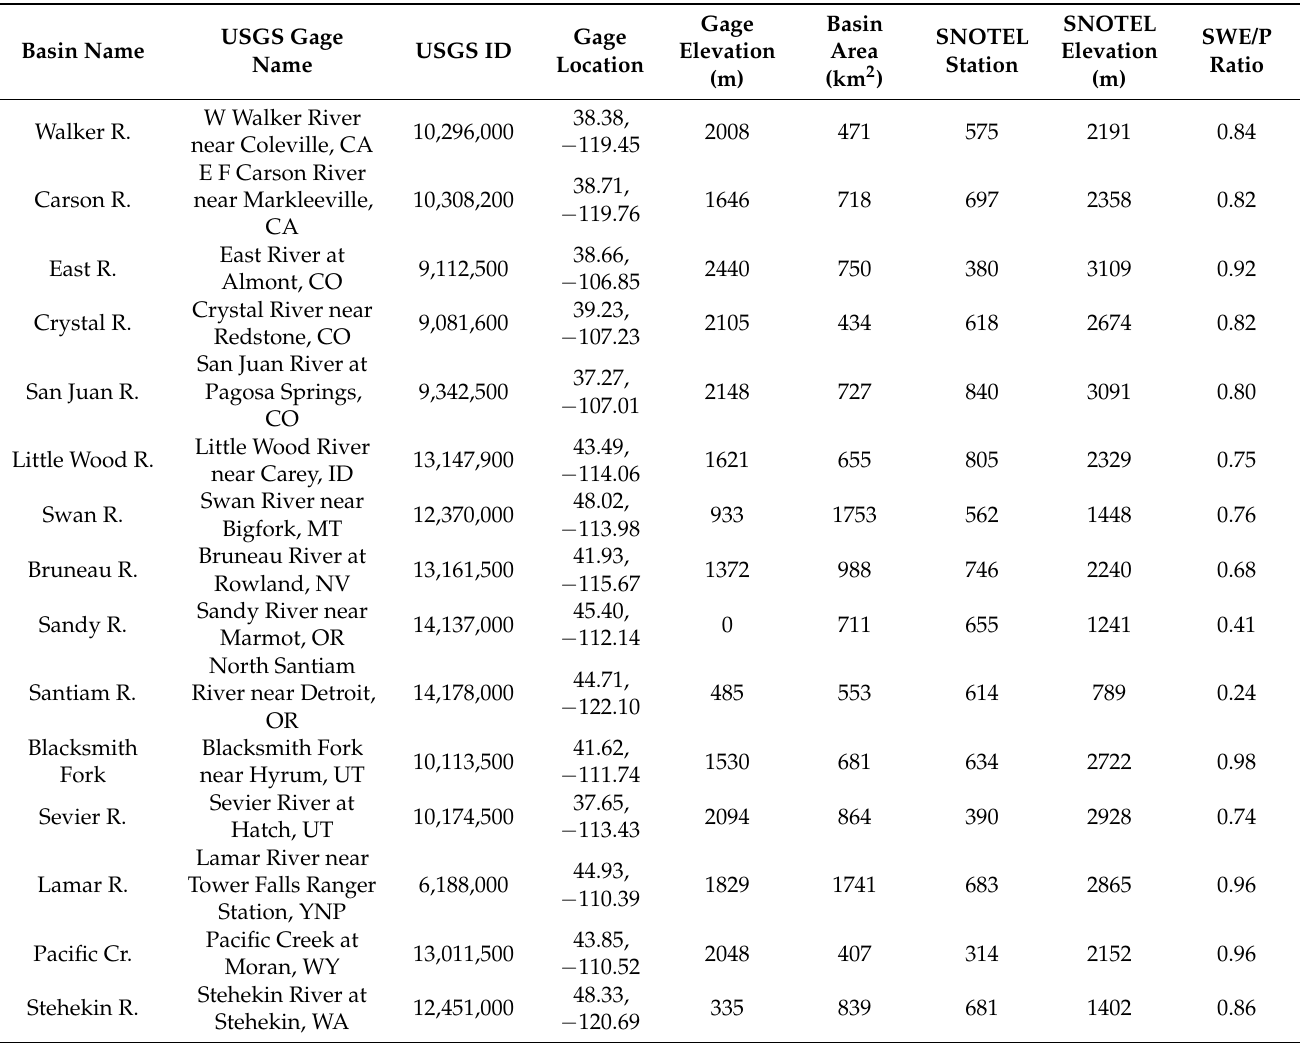
Table 1. Description of study basins and relevant attributes. SWE/P is defined as the average ratio of 1 April SWE to cumulative precipitation, as recorded at each SNOTEL station, for the water years 1985–2020. The USGS gage names have been abbreviated for